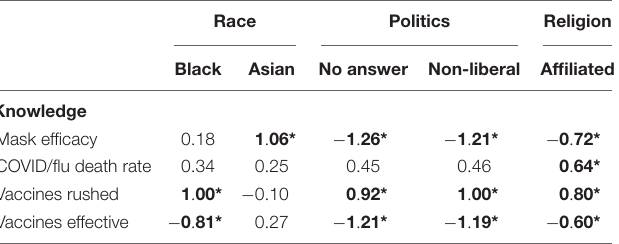
TABLE 3 | Coefficients from models predicting students’ knowledge about scientific studies regarding